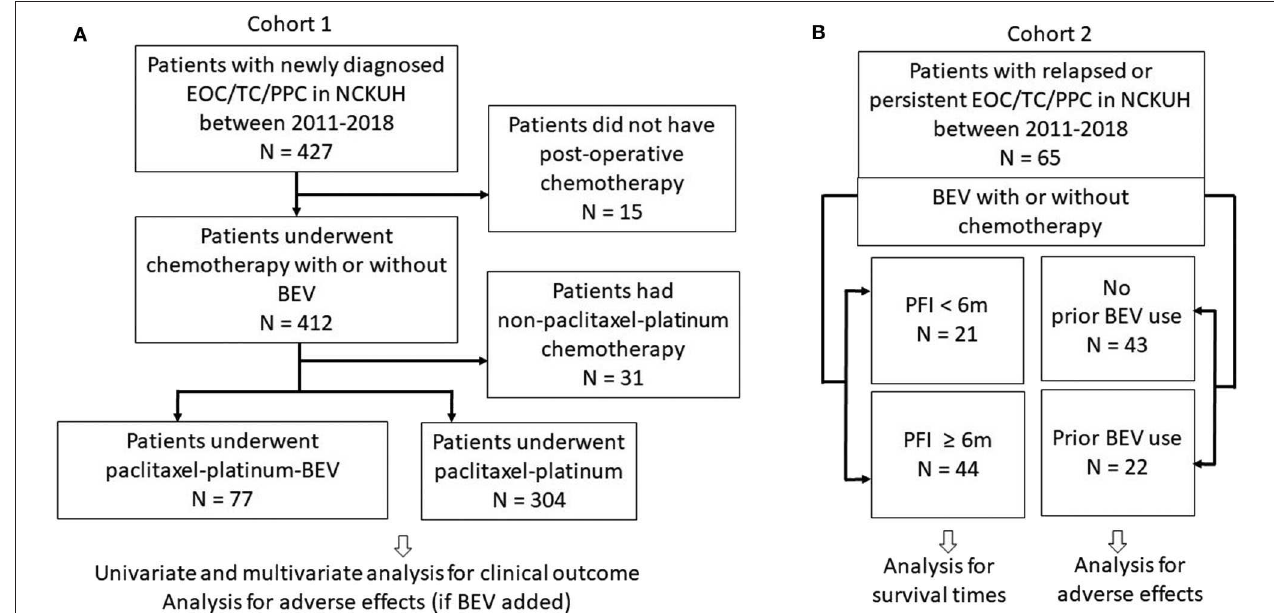
FIGURE 1 | Study flow chart. (A) Cohort 1 patients underwent first-line paclitaxel-carboplatin chemotherapy with or without bevacizumab (BEV). (B) Cohort 2 patients with relapsed or persistent disease treated with BEV ± chemotherapy. Patients were also categorized as groups with progression-free interval (PFI) < 6 and ≥